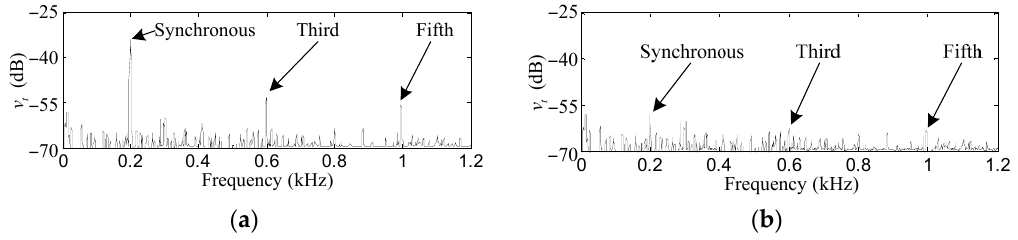
Figure 12. Experiment results of V t . ( a ) before harmonic force and torque elimination; ( b ) after harmonic force and torque elimination.